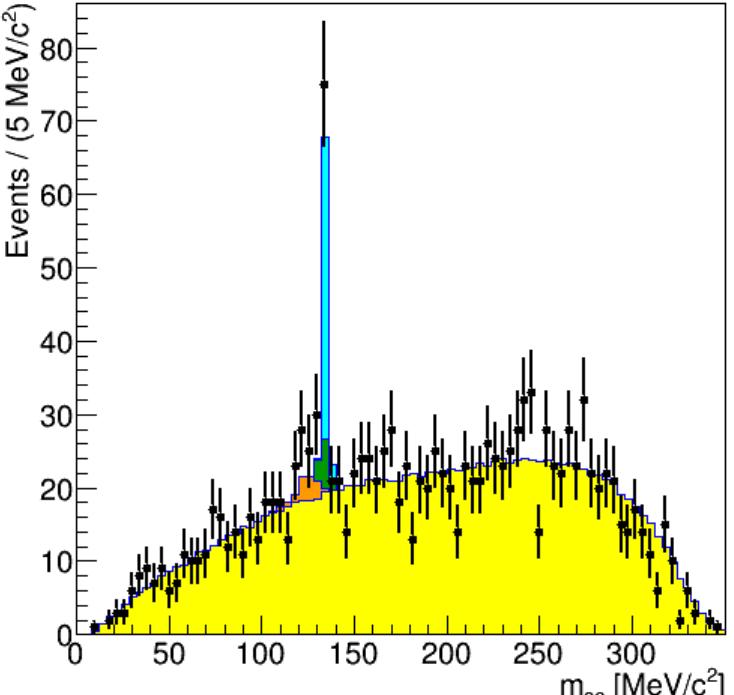
Figure 9. Reconstructed mass distribution of K + → e + e − candidates with 488 MeV/c 2 < m π ee < 500 MeV/c 2 ; data and MC estimates of various processes are visible, together with the NA62 first observation of the rare decay π 0 → e + e −